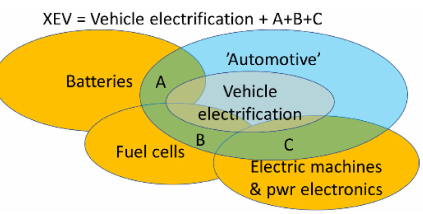
Figure 1. Search query for vehicle electrification publications (XEV).